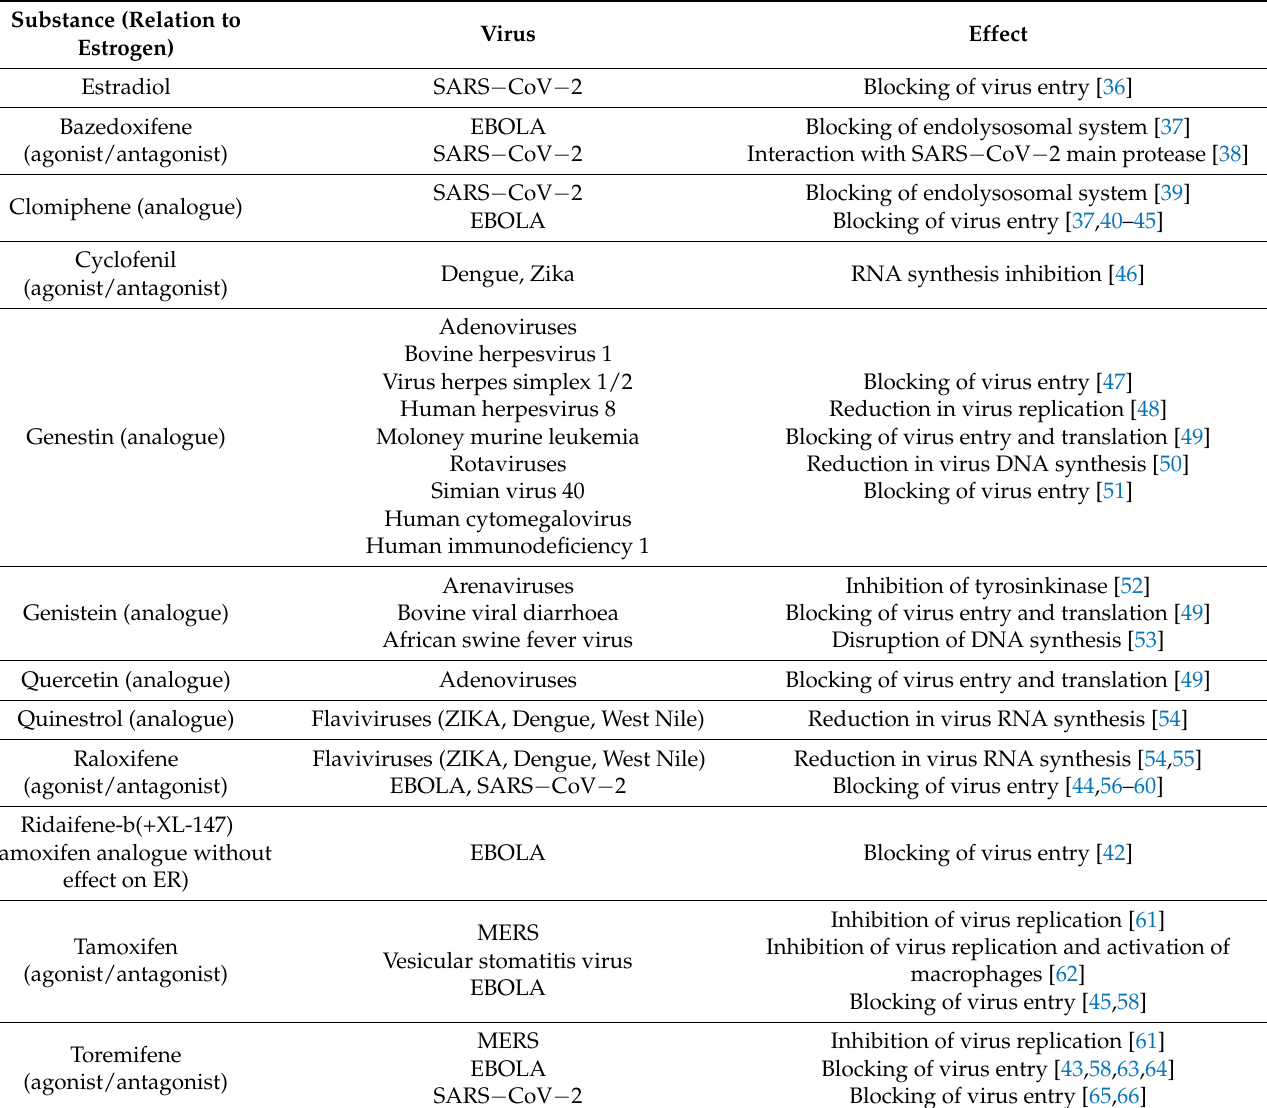
Table 1. Effect of ERMs on the biology of representative